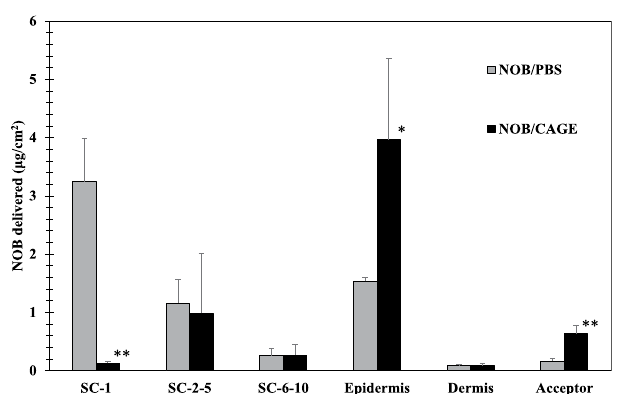
Figure 3. Evaluation of the transdermal absorption of NOB/PBS and NOB/CAGE. Thawed porcine skin without any adipose tissue was fixed with a FDC and 300 μ L of 2 mg/mL NOB/PBS or NOB/CAGE were added to the donor of the FDC and incubated for 24 h at 37 °C. After incubation, tape stripping was performed using ten tapes to get parts of the SC (SC1, SC 2–5, and SC 6–10). The remaining epidermis was scraped with a razor and separated from the dermis. The amount of NOB in the SC, epidermis, dermis, and acceptor was quantitatively determined by HPLC as described in Section 2.1.2. Each column represents the mean ± S.D. ( n = 3). For each fraction, NOB/PBS and NOB/CAGE were compared using the unpaired t test. * And ** indicate significant differences ( * P < 0.05, ** P <